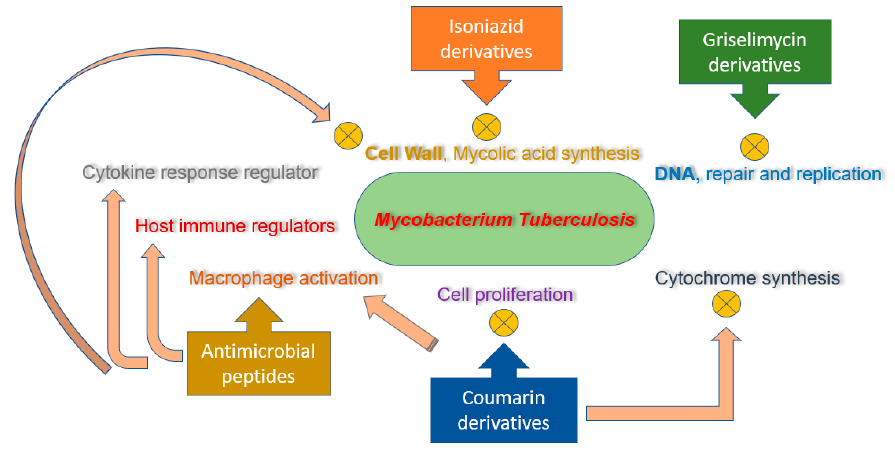
Figure 2. Mechanism of action for isoniazid, coumarin, and griselimycin derivatives and antimicrobial peptides (AMPs).